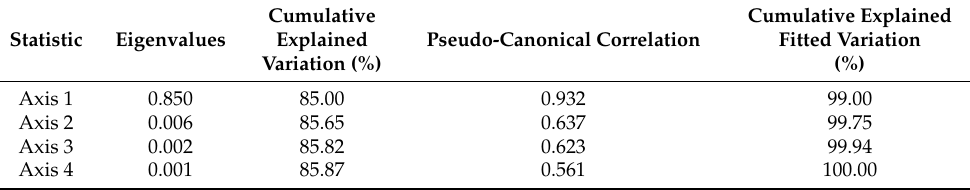
Table 1. Eigenvalues and cumulative interpretation of RDA sequence of soil enzyme